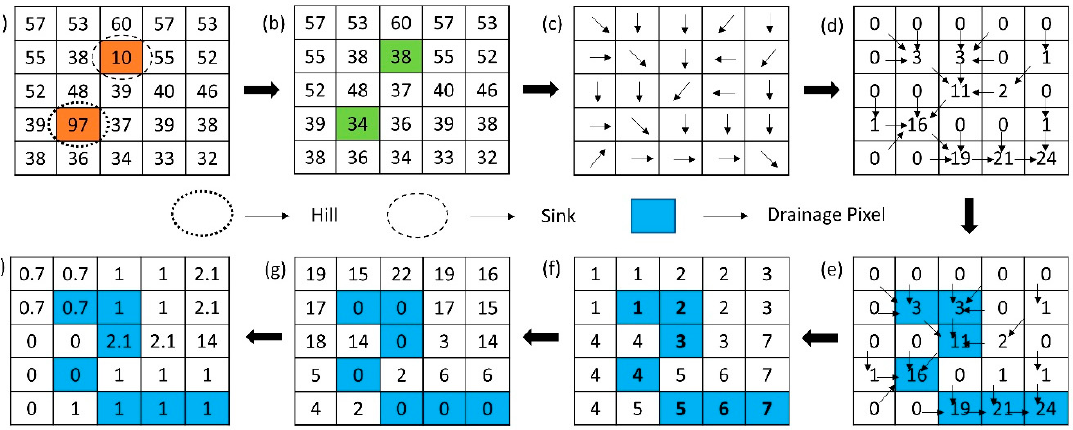
Figure 2. ( a ) Hydrologically inconsistent sample digital elevation model (DEM) with hill and sink indicated; ( b ) with DEM corrections undertaken (green); ( c ) D8 flow direction applied on corrected DEM; ( d ) flow accumulation calculated; ( e ) sample contributing area threshold of 3 applied to obtain drainage pixels; ( f ) nearest drainage pixel mapped for every other pixel in study region; ( g ) height above nearest drainage (HAND) value calculated with respect to nearest drainage pixel; ( h ) slope of nearest drainage (SND) assigned to corresponding floodplain pixels.